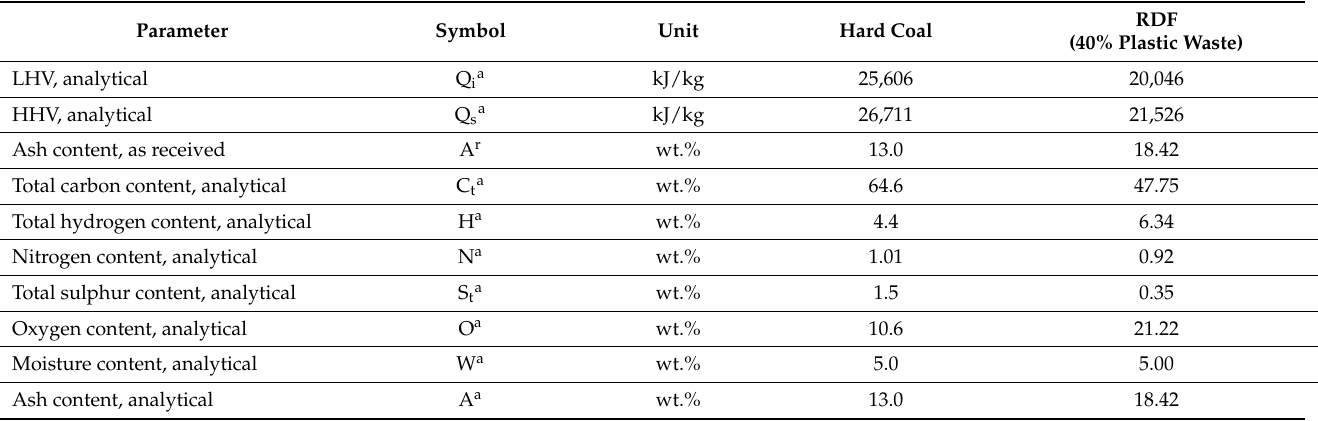
Table 4. Physicochemical properties of hard coal and RDF.